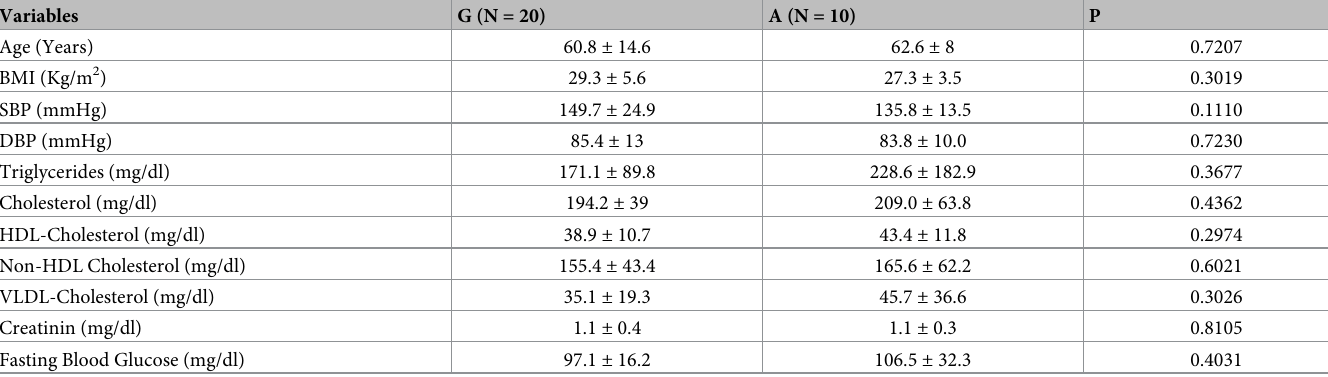
Table 8. Analysis of the influence of ACE2 G8790A polymorphism on clinical-laboratory variables among HAS male patients.